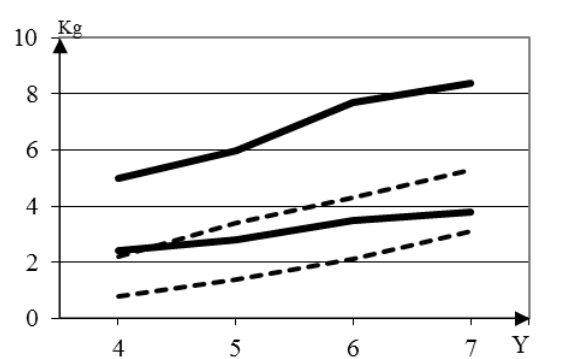
Fig. 6. Comparative characteristics of weight (P, Kg) from